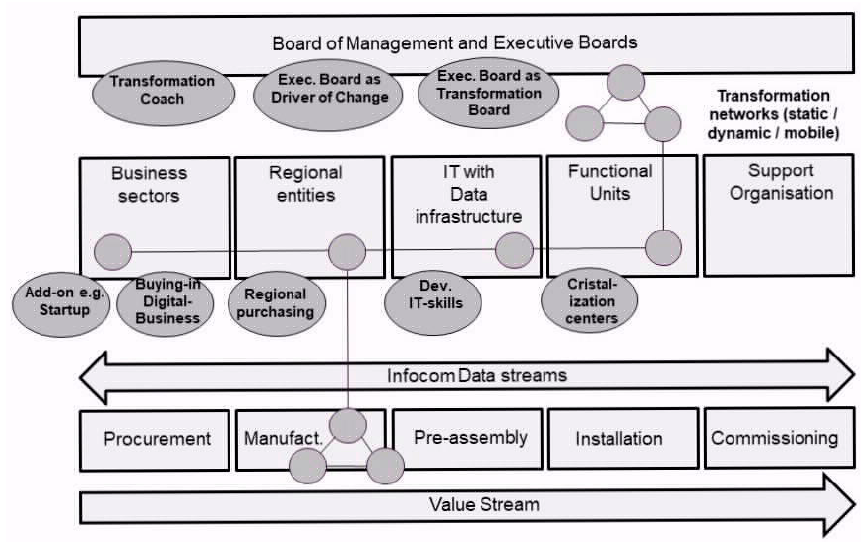
Figure 3. Generic paths for transformations to Industry Generation 4.0.